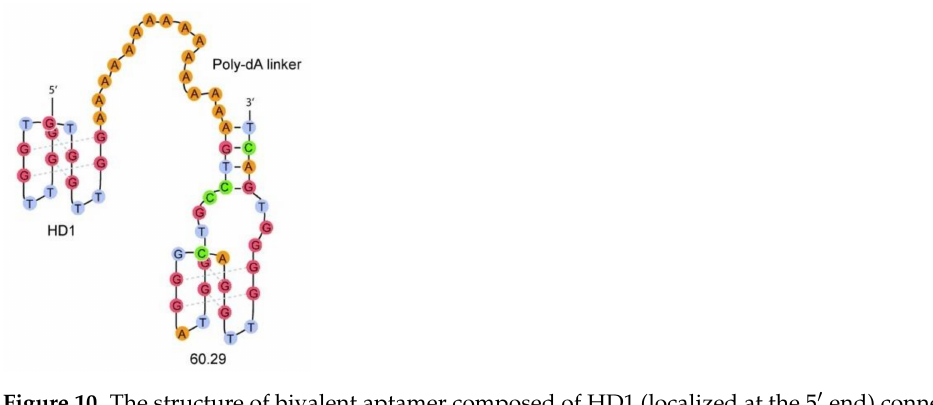
Figure 10. The structure of bivalent aptamer composed of HD1 (localized at the 5 (cid:48) end) connected with 60.29 (HD22(29)) via a poly-dA linker [81]. Reproduced with permission from John Wiley and Sons, © 2007 Wiley-VCH Verlag GmbH & Co. KGaA,